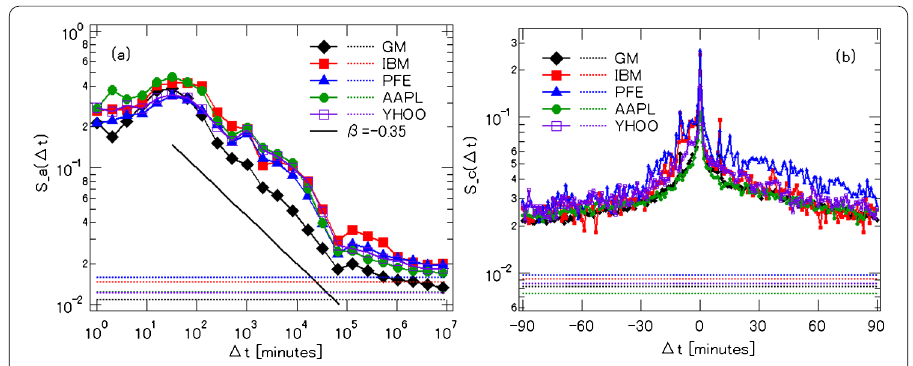
Figure 3 Cosine similarity functions for GM, IBM, PFE, AAPL, and YHOO. Panels ( a ) and ( b ) show auto cosine similarity functions and cross cosine similarity functions, respectively. The dashed lines represent the result obtained using the randomized data (i.e., the timing of news arrival is randomized). The solid line in ( a ) is a reference line representing a power law with an exponent of